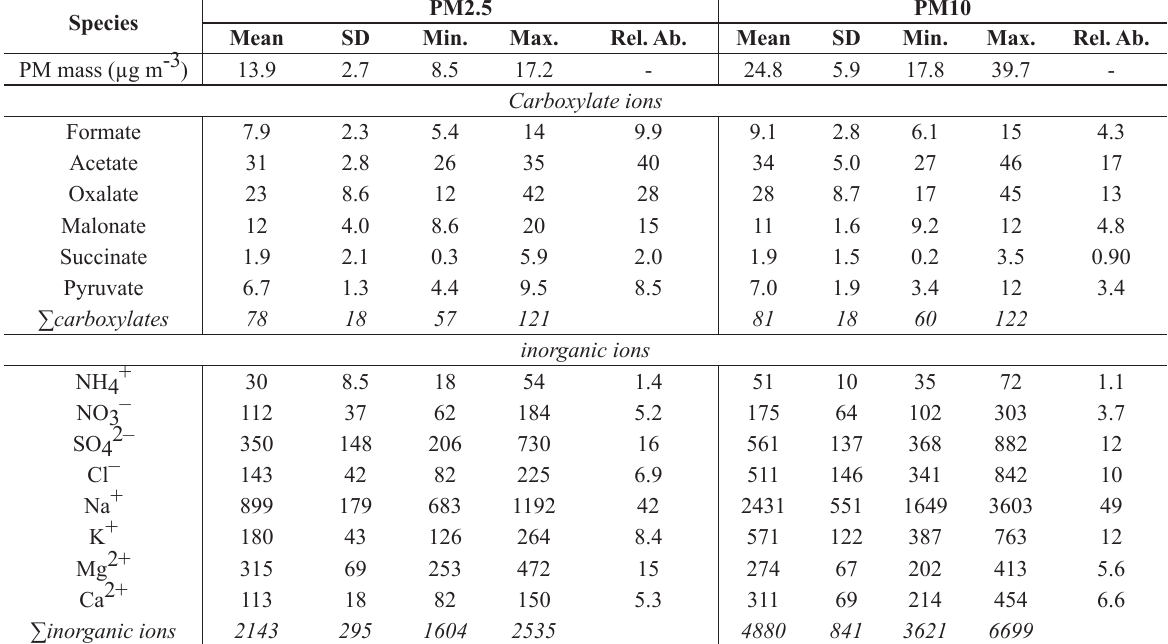
Mean concentrations and associated standard deviation, ranges (ng m -3 ) and relative abundances (%) of carboxylate and inorganic ions in PM2.5 and PM10 aerosols from BNA in